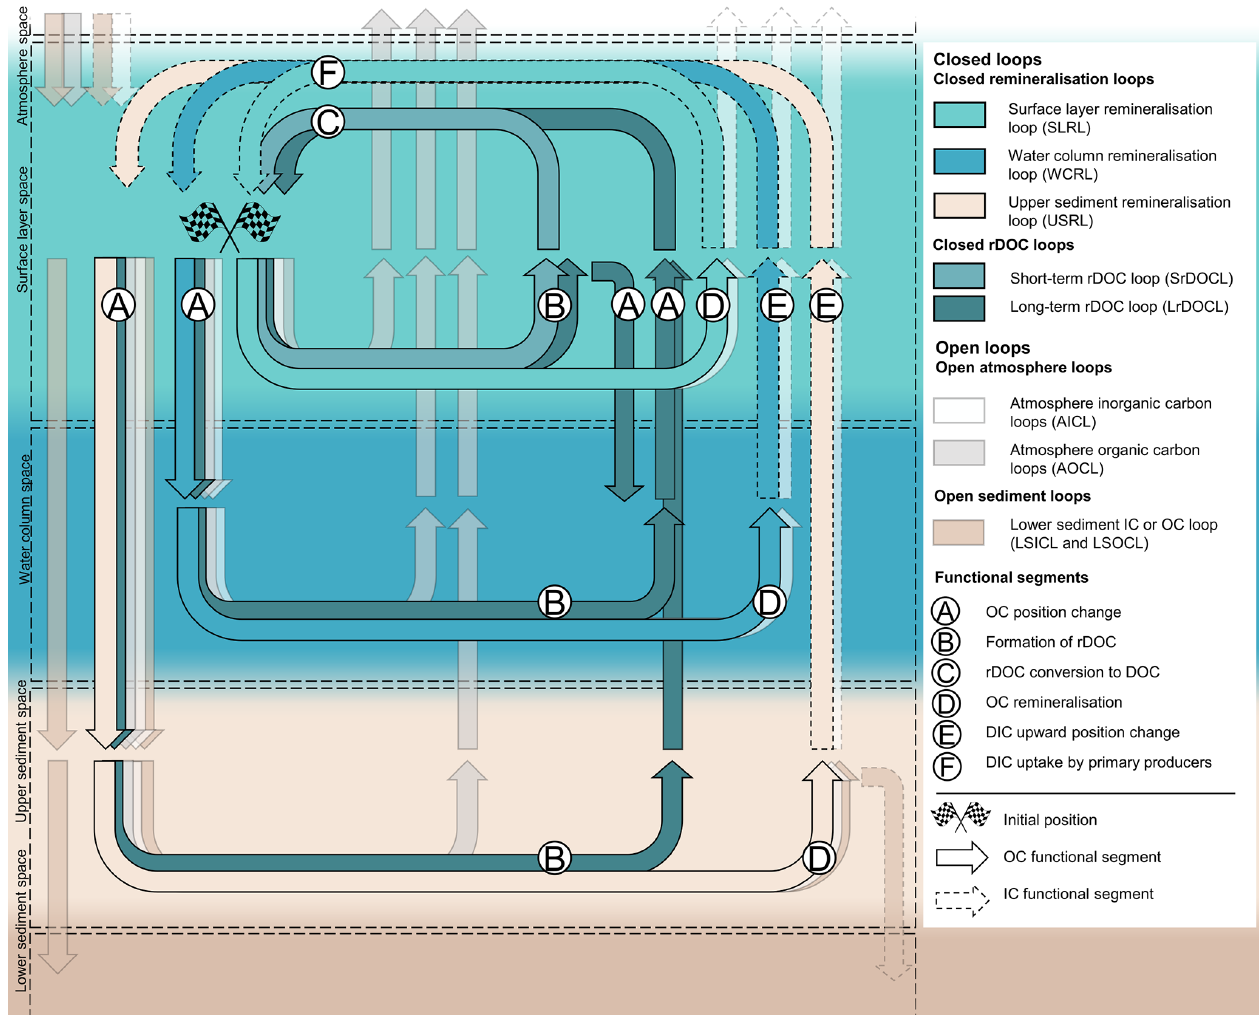
Figure 1. General structures of the marine OC cycling with three closed remineralisation and two closed rDOC loops, the spaces and the involved functional segments. Open loops are only displayed with transparent colours as they are not our focus. Table 2. Summary of sequences of functional segments and spaces defining the remineralisation and rDOC loops. The separation rule comes into play, when assigning a pathway to one of the defined loops. Spaces in square brackets indicate the spaces where the processes happen or end. Spaces in bold text are the naming spaces of this loop. Spaces in non-bold font are intermediate or “walk-through” spaces. Loops: surface layer remineralisation loop (SLRL), water column remineralisation loop (WCRL), upper sediment remineralisation loop (USRL), and short- and long-term rDOC loops (SrDOCL, LrDOCL). Spaces: surface layer space (SLS), water column space (WCS), and upper sediment space (USS). Functional segments: OC position change (A), formation of rDOC (B), rDOC conversion to DOC (C), OC remineralisation